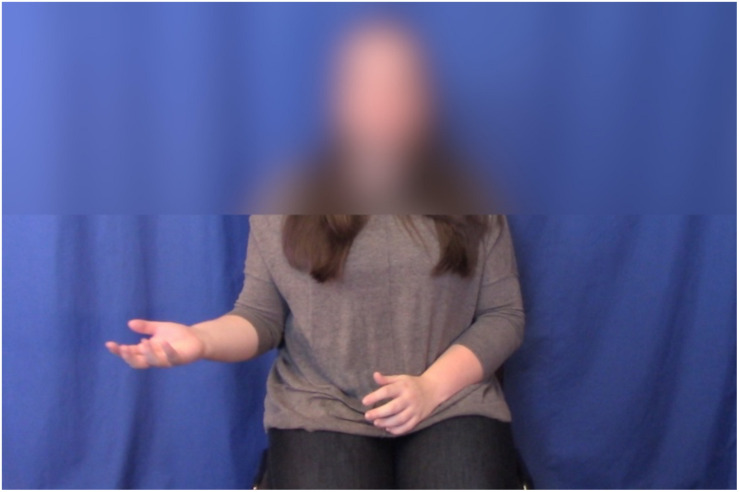
Example stimulus.